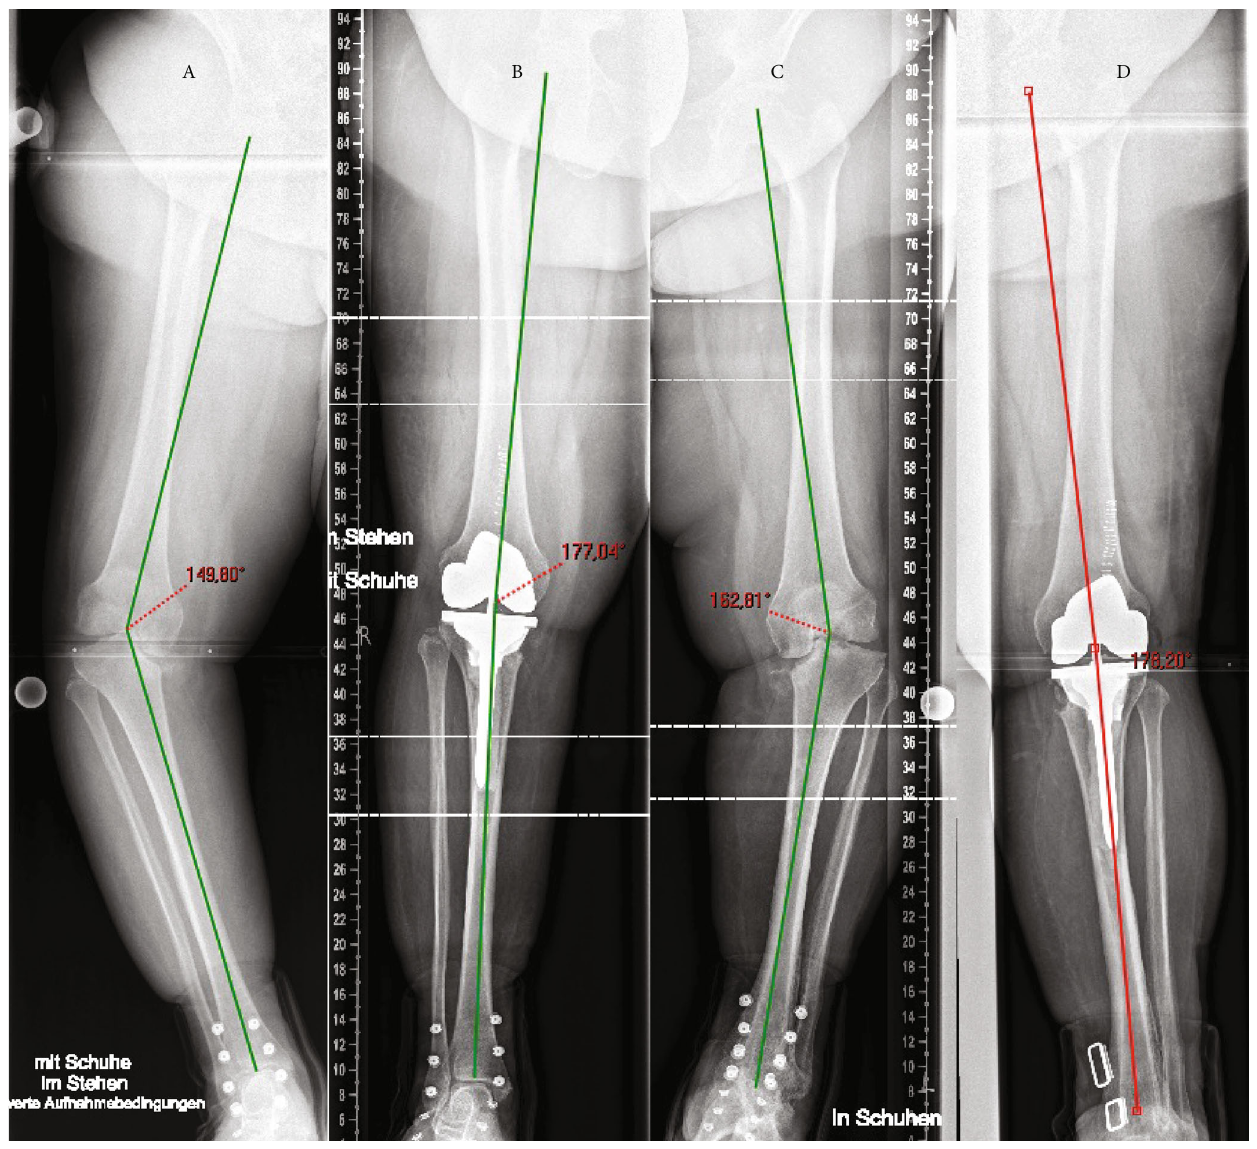
Figure 1: Standing full leg axis radiographs in orthopedic boots of both sides show a severe varus deformation of about 30 ° (a) and 17 ° (c) and the postoperative outcome with an almost neutral leg axis (b,